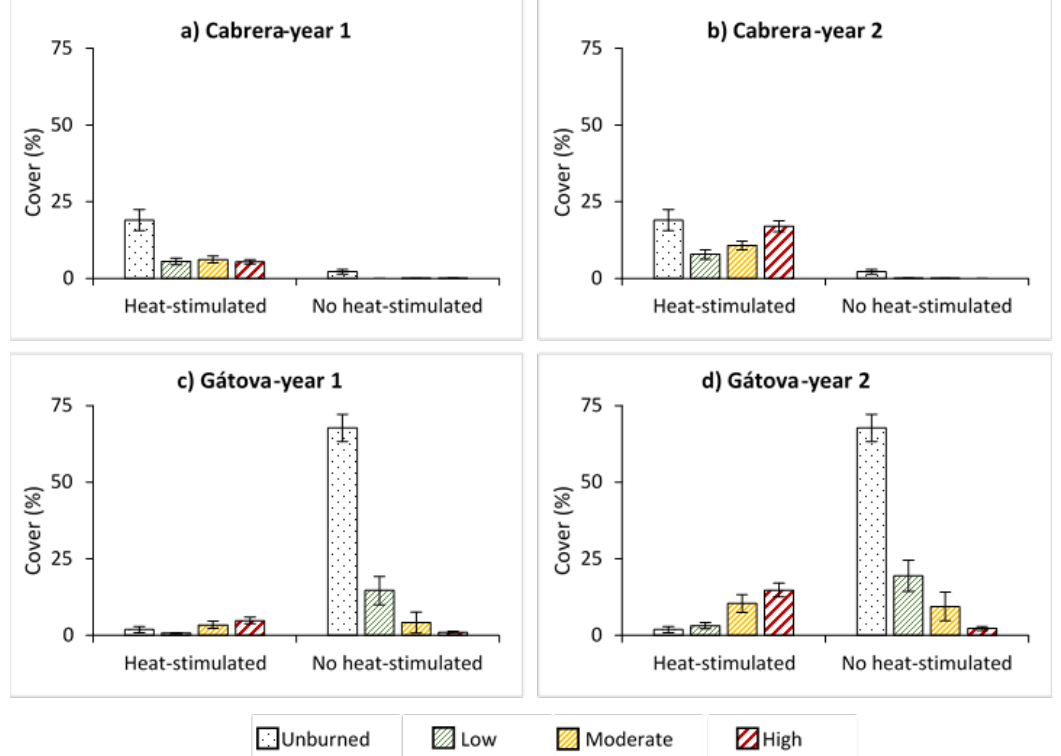
Figure 6. Average cover (%) of species with heat-stimulated and no heat-stimulated germination, and standard error for each burn severity level (unburned, low, moderate, and high) measured by the composite burn index (CBI) in: ( a ) Cabrera, one year post-fire; ( b ) Cabrera, two years post-fire; ( c ) Gátova, one year post-fire; and ( d ) Gátova, two years post-fire. Statistical information is provided in Tables S3 and S4 (Supplementary Material).